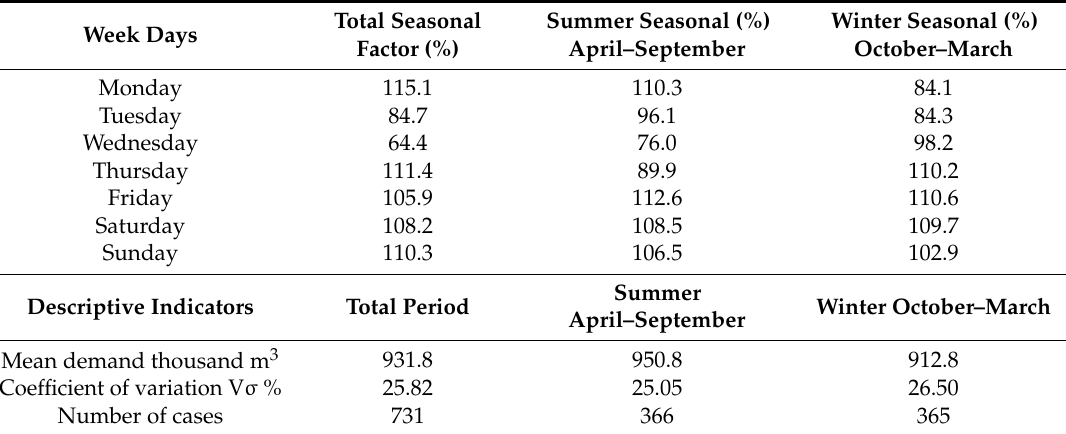
Table 4. Descriptive indicators and sales seasonal index rates (%) at daughter CNG refueling station